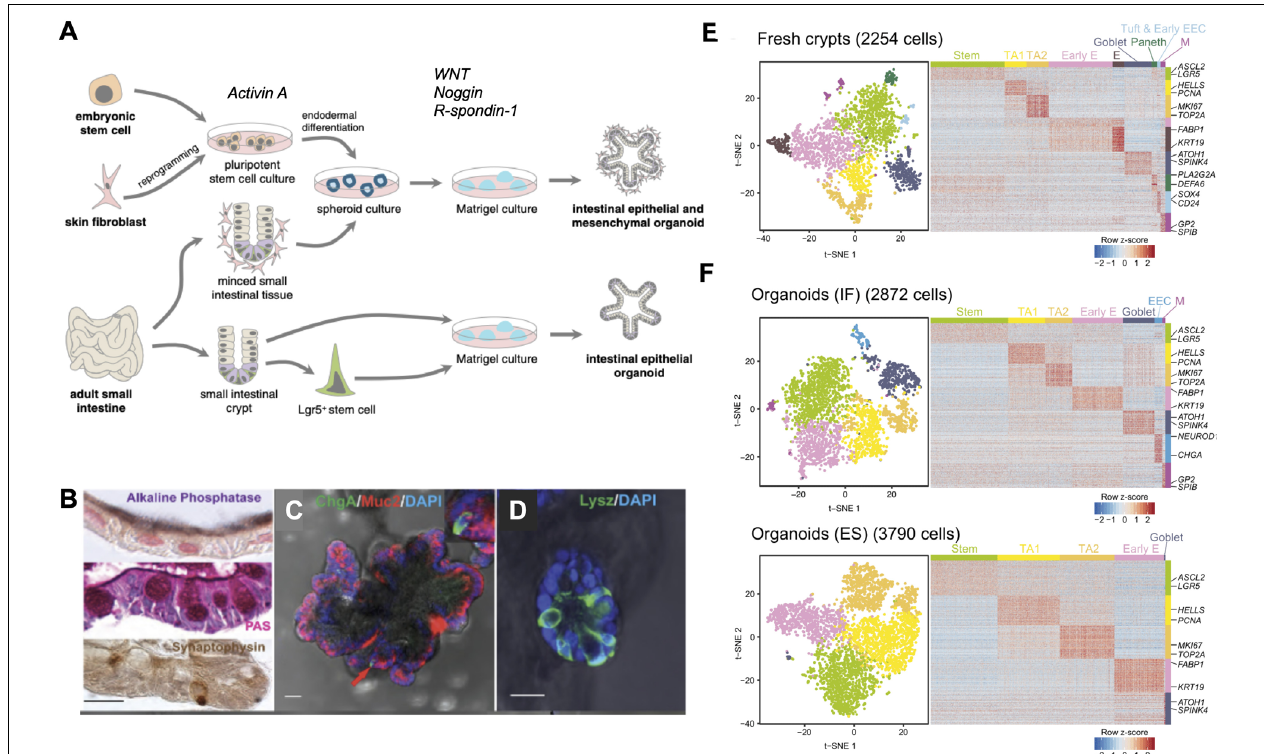
FIGURE 2 | State-of-the-art in intestinal organoids. (A) Organoids can be derived from either embryonic stem cells or induced pluripotent stem cells (iPSC) from reprogrammed differentiated cells. iPSCs grown in the presence of Activin A undergo endodermal development and in the presence of niche factors Noggin, EGF, and R-spondin-1, form intestinal organoids containing both epithelial and mesenchymal cell types. Small intestinal tissue samples can be directly cultured as spheroids to produce organoids or LGR5+ stem cells can be isolated from these tissues to produce epithelial organoids when grown in the presence of niche factors. (B) Alkaline phosphatase staining for mature enterocytes, periodic acid-Schiff (PAS) staining for goblet cells, synaptophysin staining for enteroendocrine cells. (C) Human intestinal organoids expressing Mucin 2 (red) a marker of goblet cells, chromogranin A (green) a marker of enteroendocrine cells, (D) lysozyme (green) a marker of Paneth cells. (E) Single cell RNA sequencing demonstrates cell types in conserved in fresh human ileal crypts and in (F) intestinal organoids cultured under two different conditions, standard organoids cultured with two different culturing conditions: traditional culture conditions (bottom panel) compared to a new set of culture conditions (IGF-1 and FGF-2). Scale bar demonstrates statistical association ( z -score) of specific genes with specific cell types